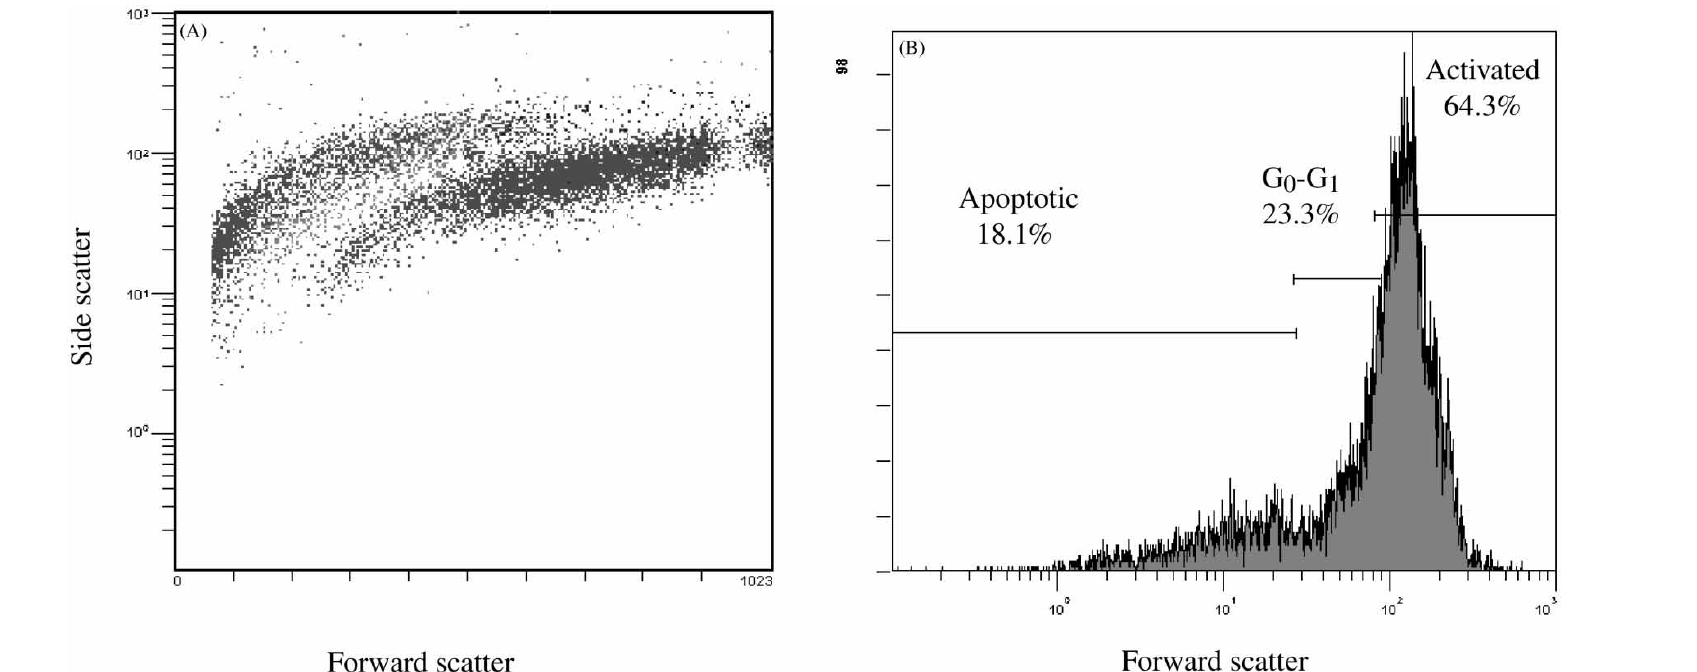
FIG. 1. Propidium iodide (PI) staining of stimulated, fixed and permeabilised cells to track cell cycle and to gate out apoptotic cells. PI, and DNA intercalating dye, serves both as a positive control for the permeabilisation of the samples with permwash, but also provides a way of marking cells in the G 0 (cid:1) / G 1 , G 2 (cid:1) / S and most importantly, apoptotic pathway. Cells with less than one copy of their DNA are undergoing the later stages of apoptosis. Colored gating with the EXPO32 ADC software (Applied Cytometry Systems, Sacremento, California, USA) on the FL3 histogram (B) allows visualisation of the apoptotic cells so that they can be excluded from the live cell gate (A) used in later samples to minimise the fluorescent contamination of staining induced by highly auto-fluorescent dead